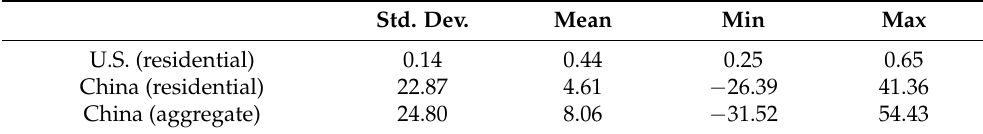
Table 2. Year-on-Year growth rate of land (%).